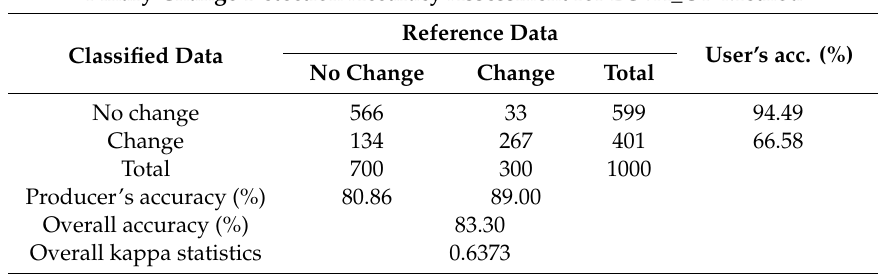
Table 3. Error matrix and accuracy assessment for binary change detection with ECVA_OB and MCVA_PB